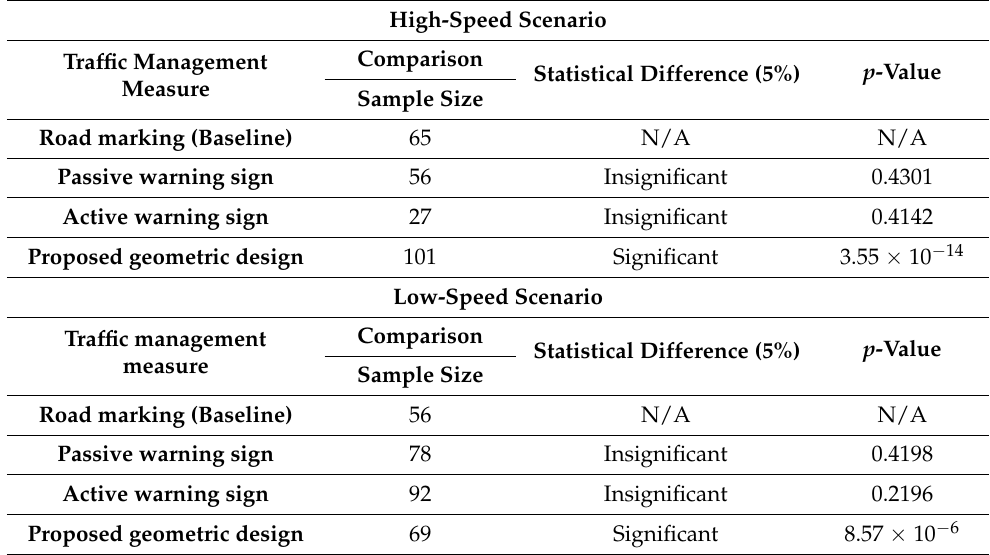
Table 2. Comparison of average speeds at conflict